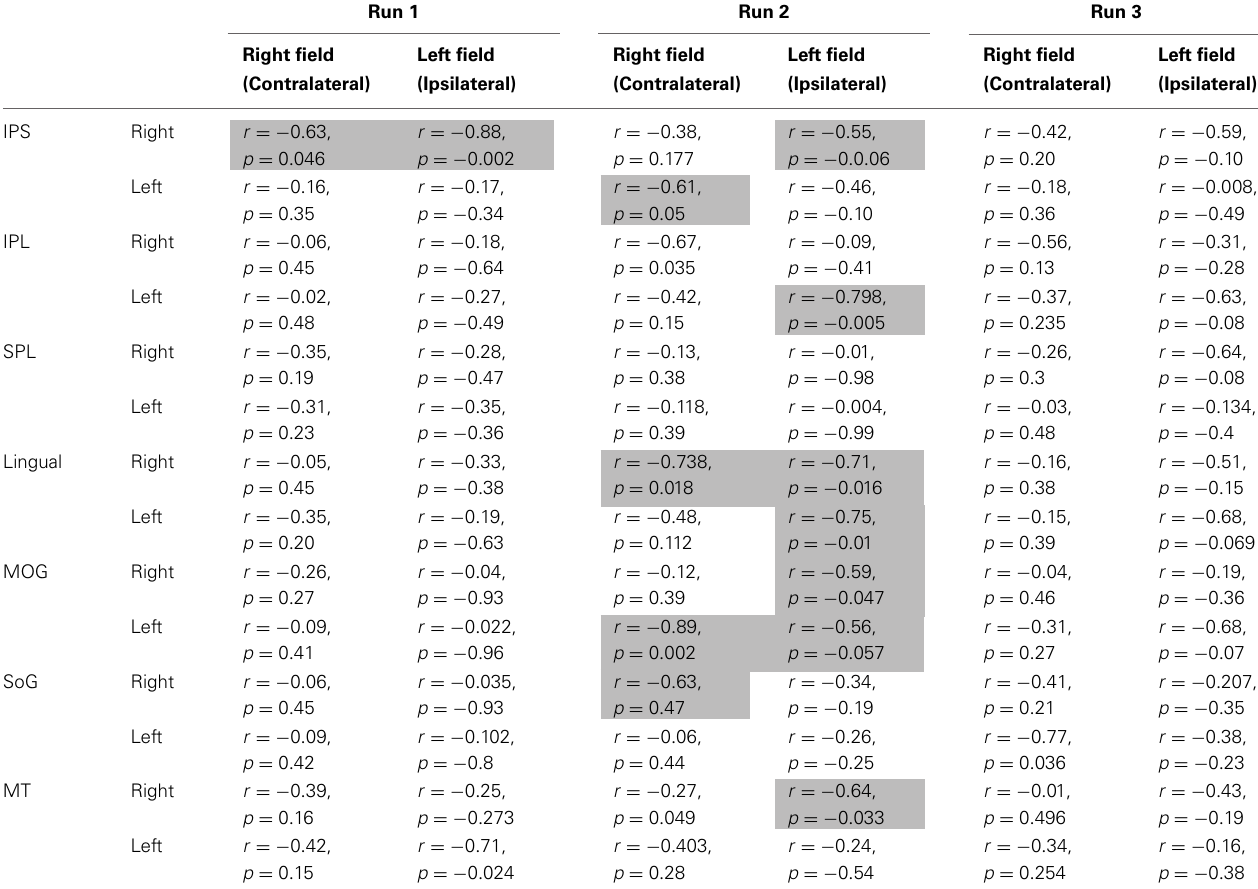
Table 2 | Activation-accuracy